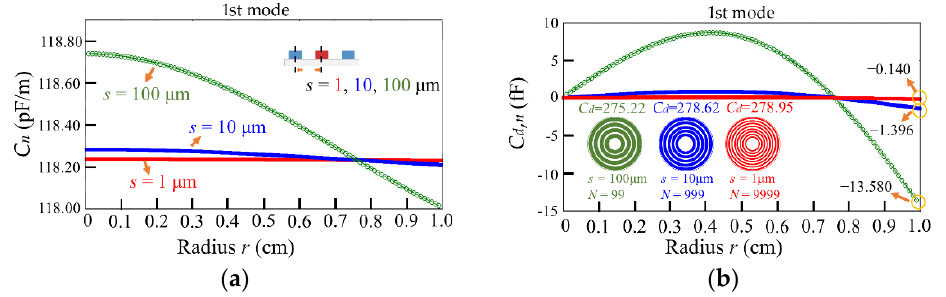
Figure 7. ( a ) The capacitance per unit longitudinal length C n ( C in + C out ) and ( b ) the capacitive variation in the electrical rings ( C d , n ) along radius of membrane for the 1st mode at the gaps s = 100, 10, and 1 μ m.